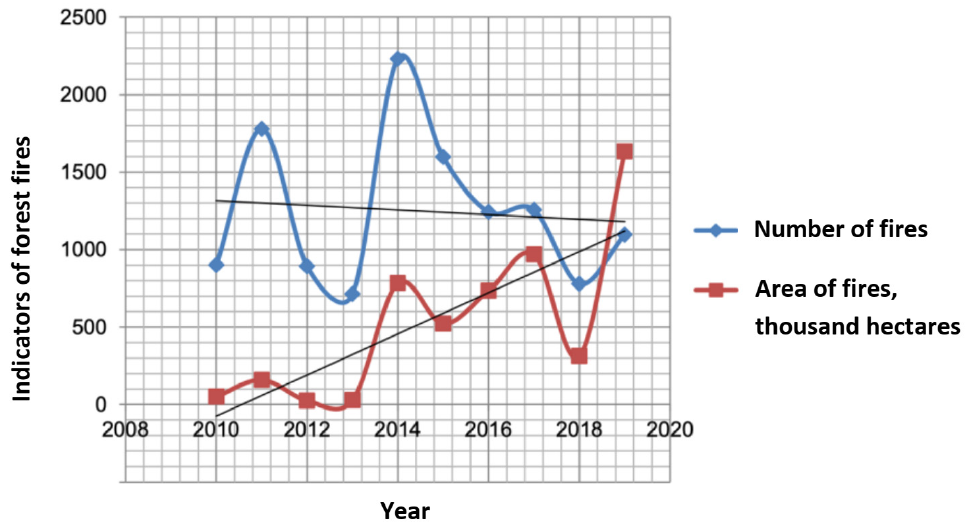
Figure 1. Statistics of forest fires in Irkutsk Oblast [59].